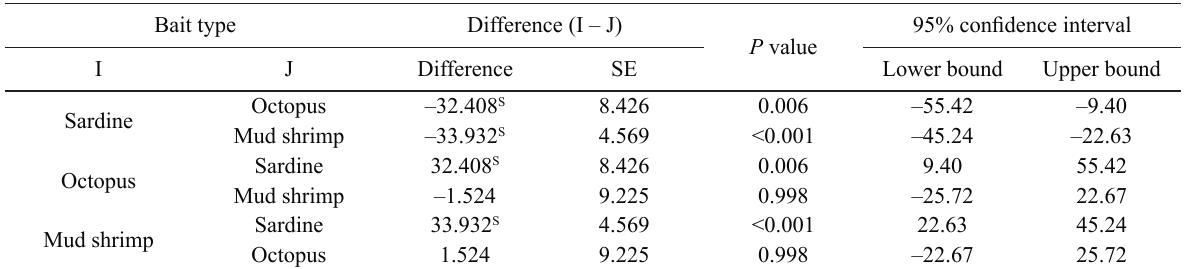
Summary of post-hoc test, for multiple comparisons of the bait